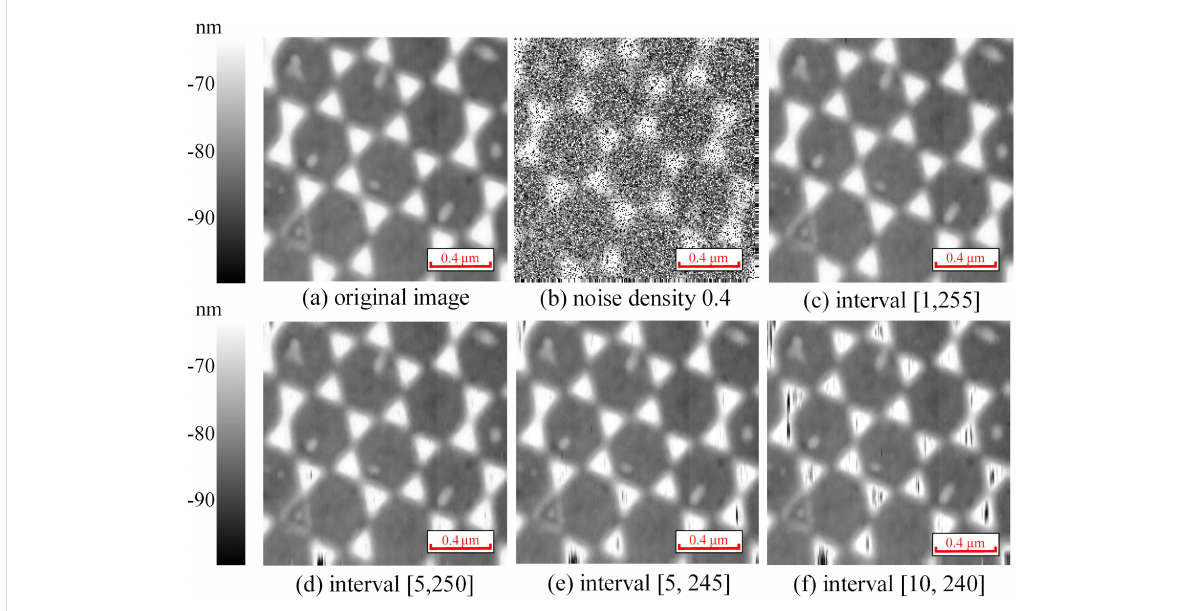
Figure 4: Comparison of interval-BCS denoising with different upper and lower limits. (a) Original image. (b) Image with added impulse noise with a density of 0.4. (c) Upper limit of 255 and lower limit of 1; PSNR = 40.8 dB, SSIM = 0.97, the runtime is 9.4 s. (d) Upper limit of 250 and lower limit of 5; PSNR = 33.3 dB, SSIM = 0.96, the runtime is 9.4 s. (e) Upper limit of 245 and lower limit of 5; PSNR = 29.3 dB, SSIM = 0.94, the runtime is 9.7 s. (f) Upper limit of 240 and lower limit of 10; PSNR = 23.1 dB, SSIM = 0.91, the runtime is 9.7